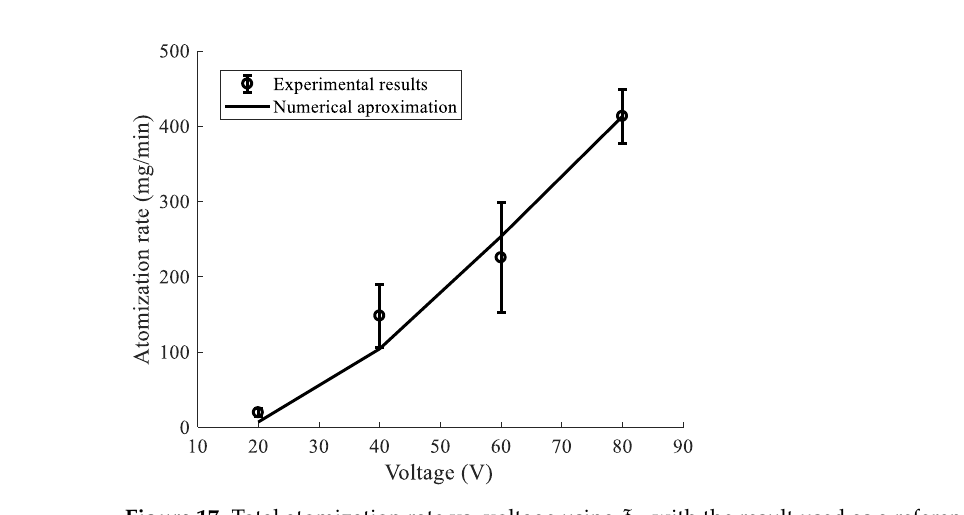
Figure 17. Total atomization rate vs. voltage using 𝜉 𝑎 , with the result used as a reference threshold in the calculation of the displaced volume.